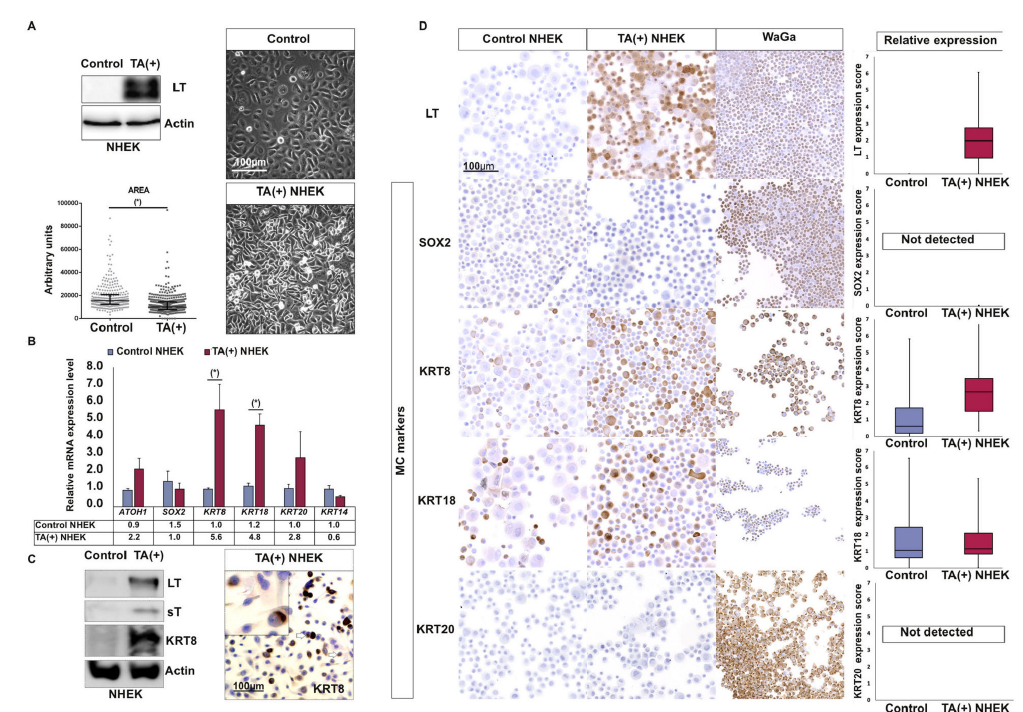
Figure 3. T antigens induce expression of some early MC di ff erentiation markers in primary human keratinocytes. A: NHEKs were infected with a lentiviral vector coding for small T (sT) and truncated Large T (LT) as well as a puromycin resistance. Following antibiotic selection, cells were analyzed